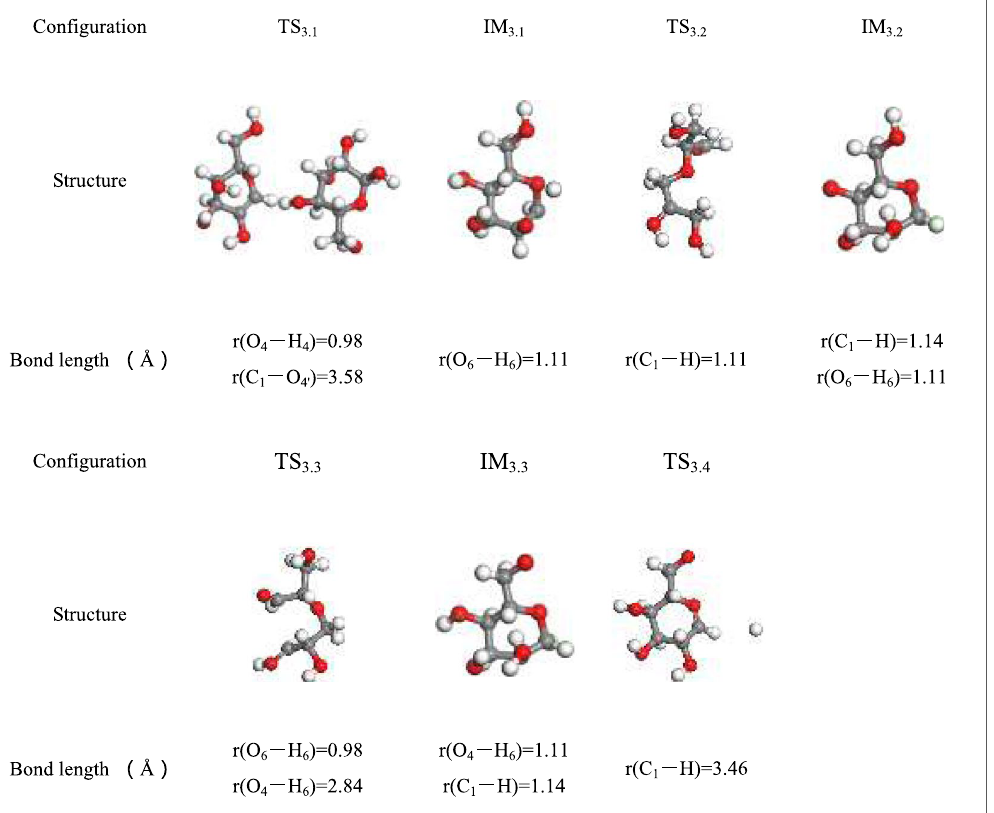
Table 4. Optimized configuration in pathway